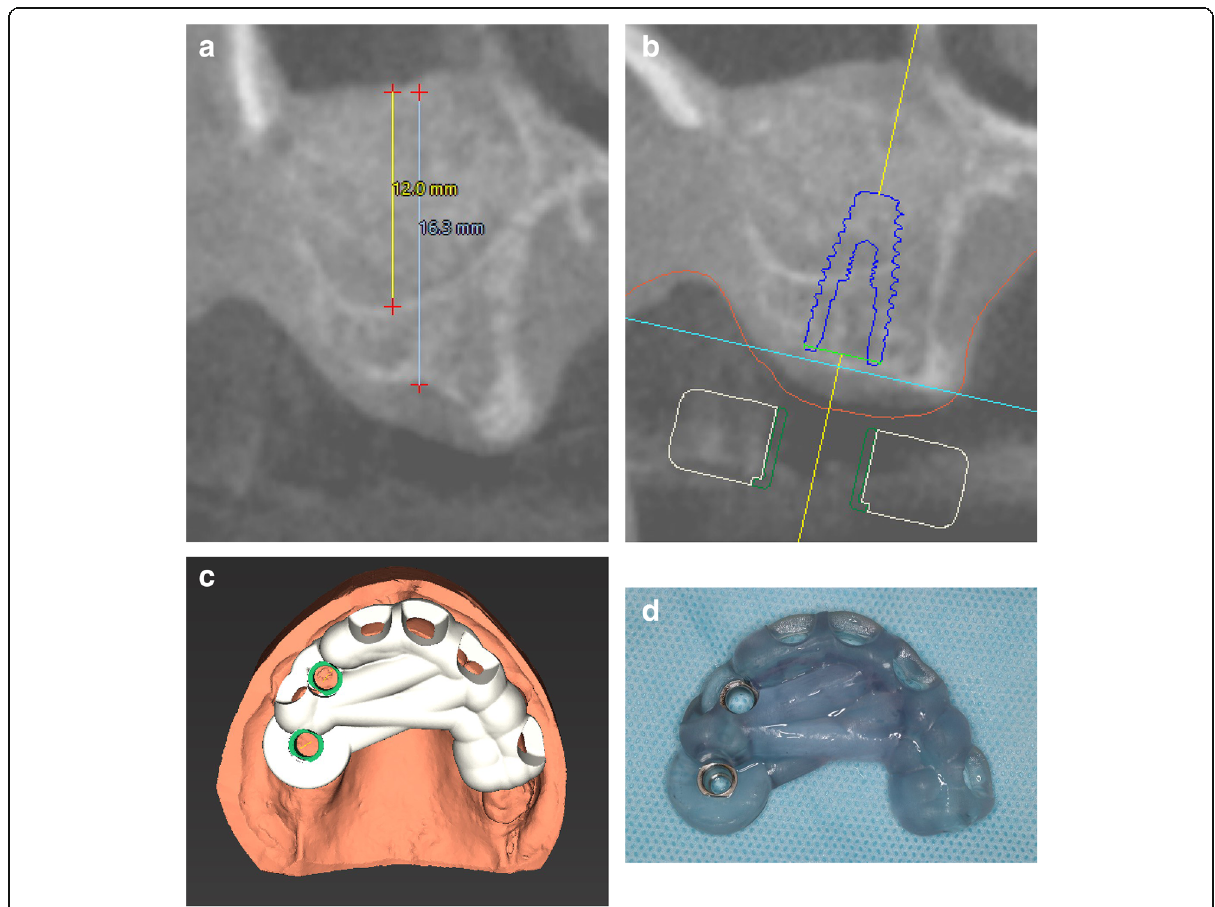
Fig. 4 a 14 weeks follow-up CBCT to plan for implant placement. b Planning implant position into the grafted sinus using coDiagnosticX software. c Digital design for the surgical guide. d 3D-printed surgical guide